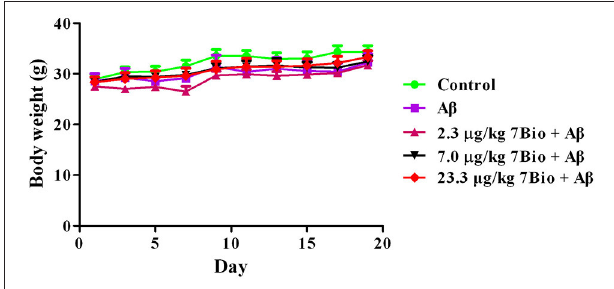
FIGURE 4 | Treatments do not significantly alter motor function of mice in the open field tests. The number of rearings and line crossings were recorded and calculated as shown in (A) and (B) , respectively. Data are expressed as the mean ± SD ( n = 10).